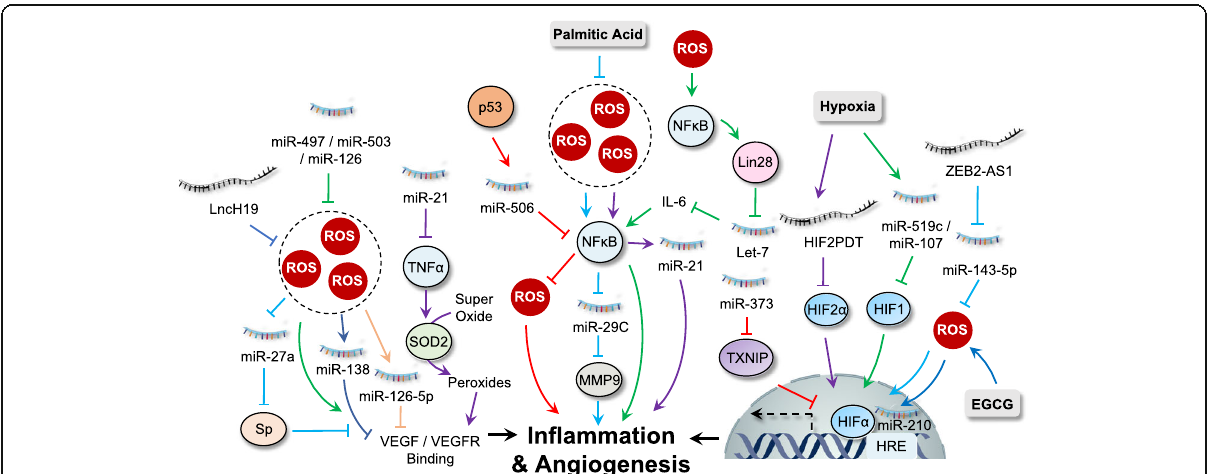
Fig. 5 Interplay between ROS and ncRNAs in regulating inflammation and angiogenesis. ROS and ncRNAs regulate cancer inflammation and angiogenesis mainly by targeting NF- κ B, HIF-1 α and VEGFR